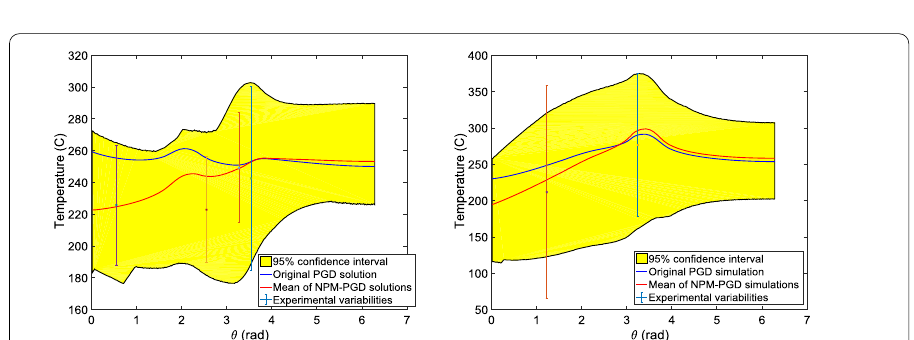
Fig. 8 Enrichement of the deposition of the fifth layer using the NPM for PGD algorithm, l = 3. Temperatures in C